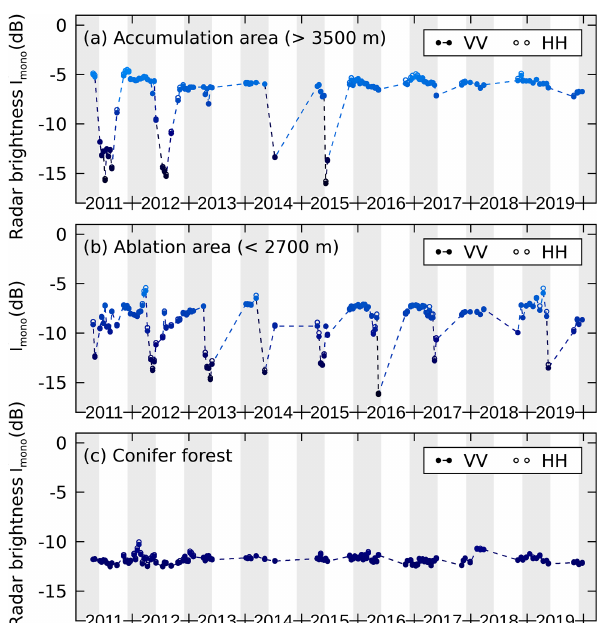
Figure 10. Time series of the monostatically measured radar bright- ness ˆ I mono observed by the satellite TanDEM-X for three different land cover types: (a) deep firn in accumulation areas above 3500m and (b) the tongue of the Great Aletsch Glacier which is covered by 0–3m of snow in winter. In (a) and (b) seasonal variations in I mono provide a good indicator for distinguishing between dry and wet snow. Gray shading indicates the period 1 December–31 May when dry firn is most likely present in the accumulation zone. This period was selected for estimation of the absorption and scattering lengths (cid:51) A and (cid:51) T . A backscatter difference between the VV and HH po- larized data is hardly visible. (c) Compared to snow, forest (mainly conifer forest) shows only small variations in the radar brightness when summer and winter acquisitions are available (2011–2013).